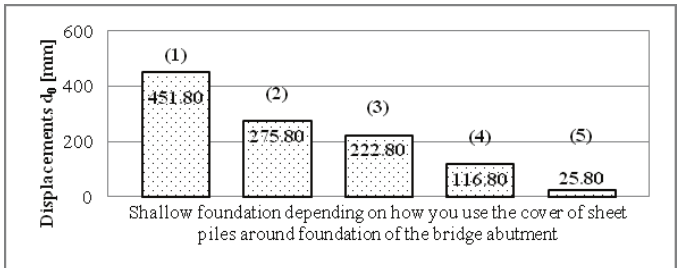
Fig. 8a. Displacements d 1 (mm) depending on the use of sheet piles as a cover of the foundation. The most unfavorable combination of load cases